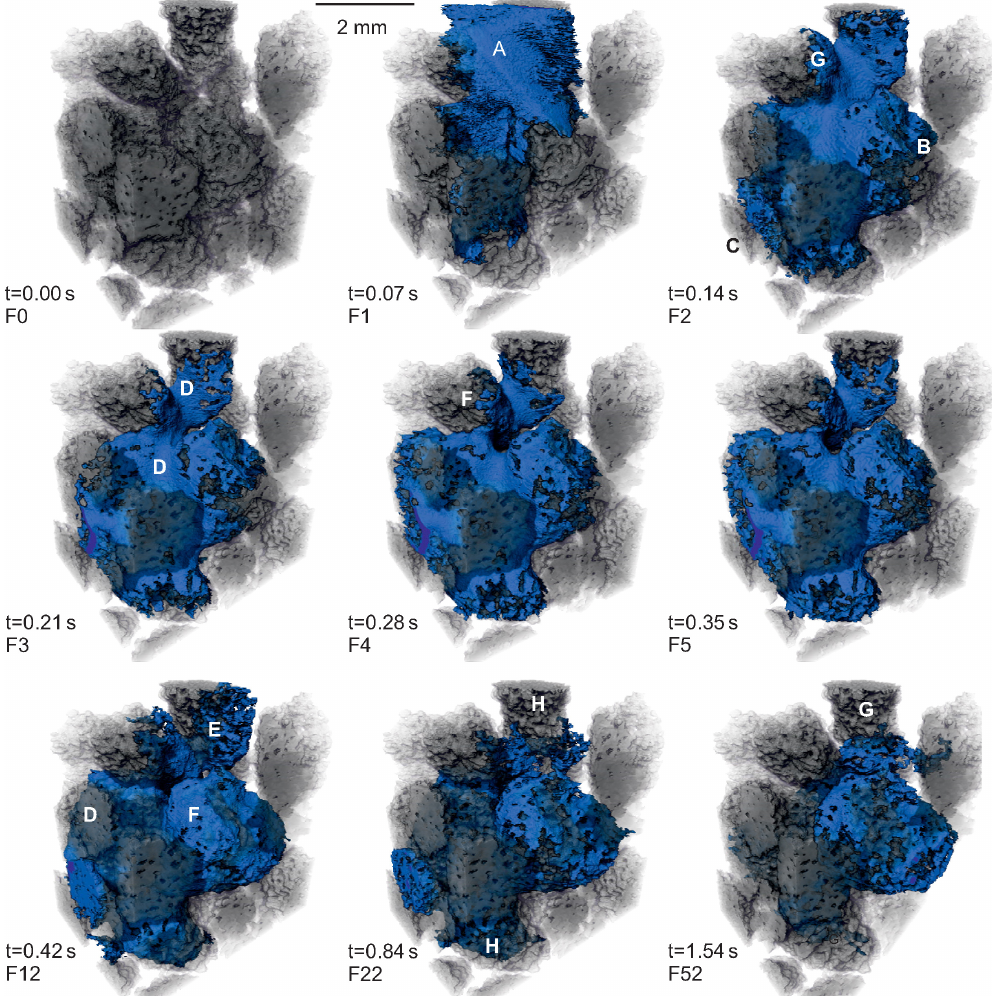
Figure 3. Time series showing the wetting of the sandstone gravel under the first drip. Three-dimensional frame acquisition fre- quency = 0.07/3-D volume (14Hz). The first frame shows the dry sample with the sandstone grains rendered in semi-transparent grey. From the second frame the KI solution is shown in blue. Note the rapid changes in both the inter- and intra-grain fluid distribution (see text for discussion). The rendered volume is a small sub-volume of the larger dataset and shows a volume approximately 3.5mm × 3.5mm × 2mm. Data are from sample LH_9, scan